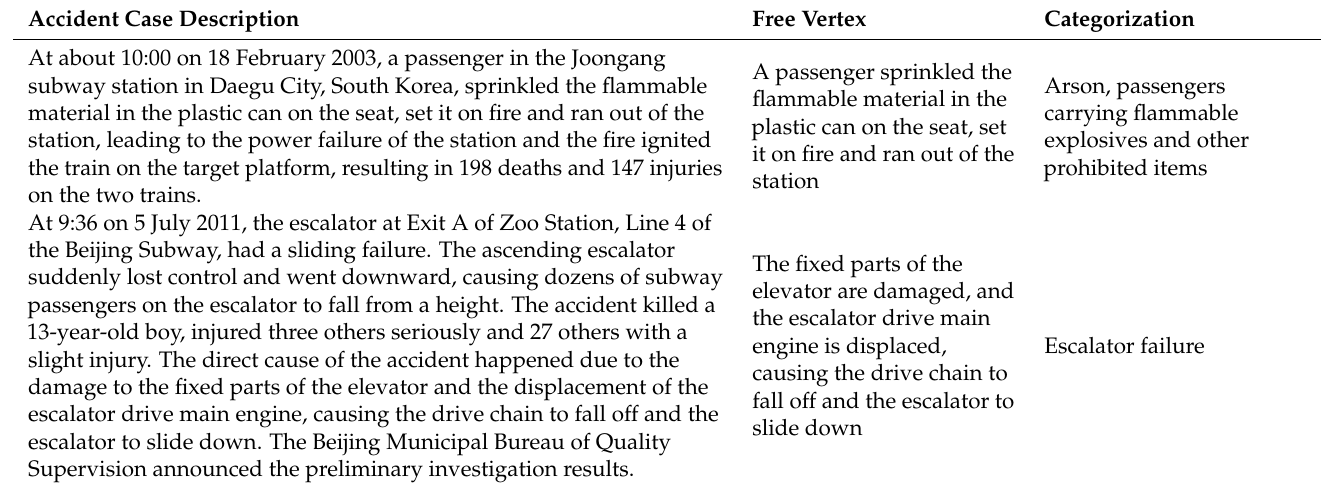
Table 2. Examples of open coding of subway operation accidents’ risk factors.